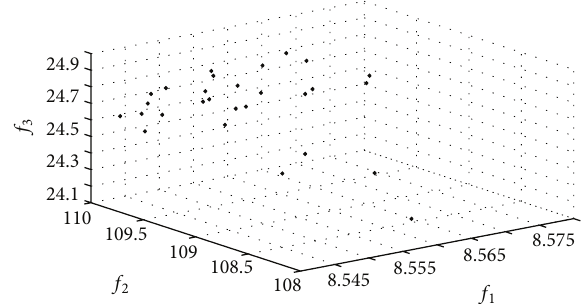
Figure 4: The Pareto frontiers of the HPSO algorithm.